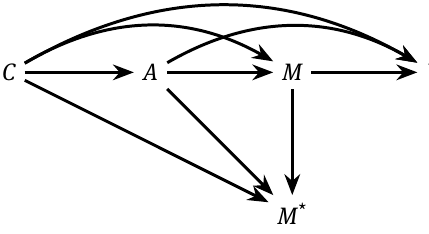
Figure 5: Differential misclassification in the measurement of mediator M * in mediation analysis